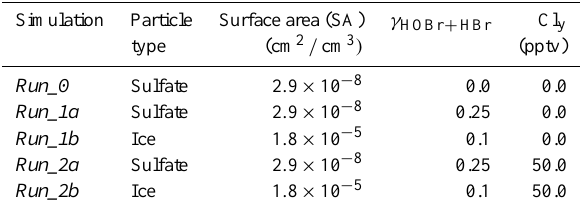
Table 2. Description of inputs for various box-model